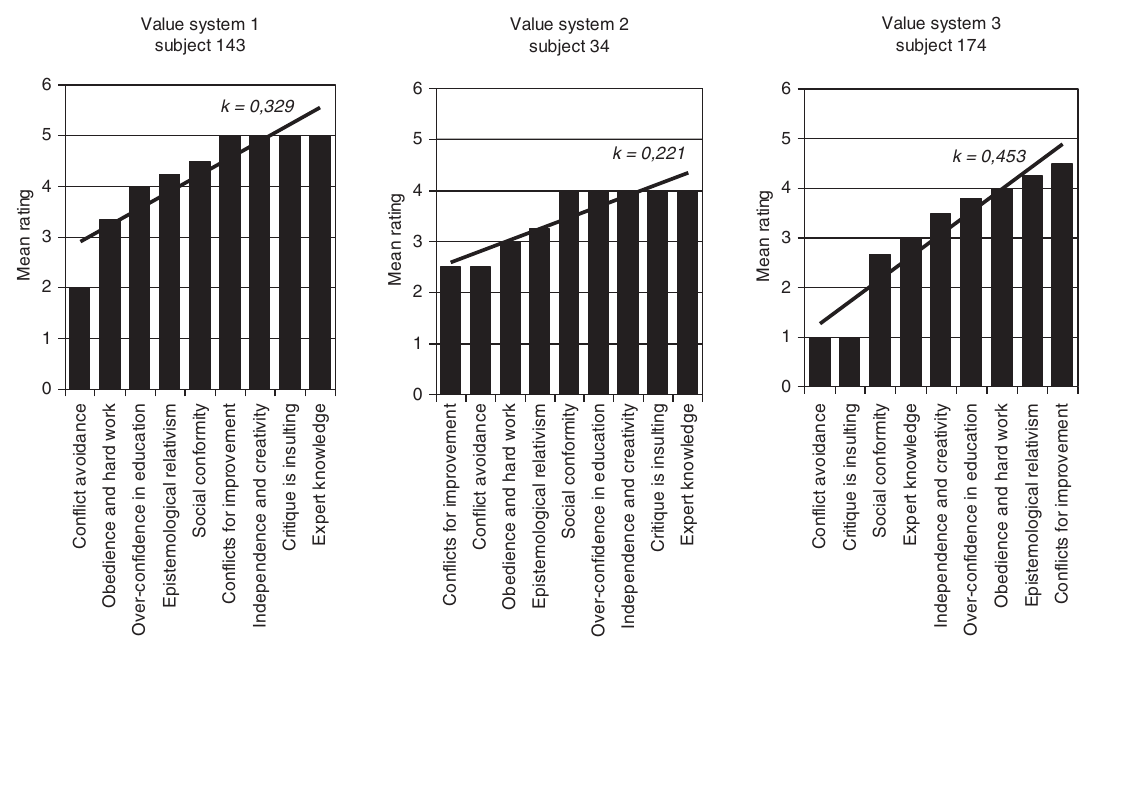
Figure 1. Indi v idual examples of slope ( k ) calculated by simple linear regression to fit the mean rating of 9 v alue clusters identified in the factor analysis and arranged according to